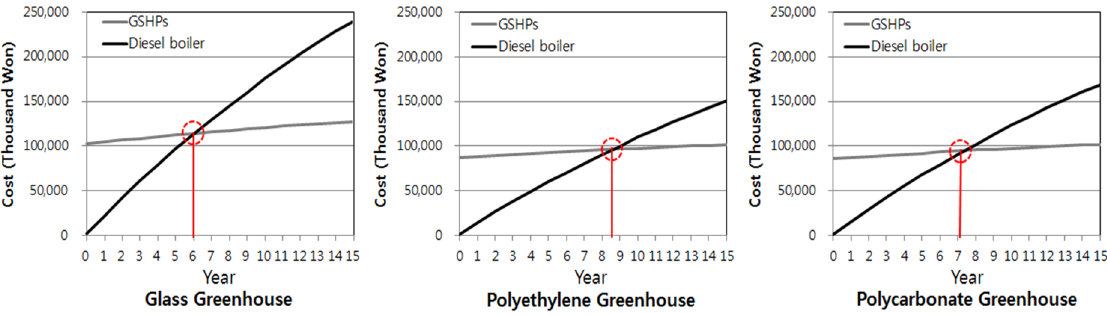
Figure 10. Life Cycle Cost (LCC) comparative and payback period analysis.